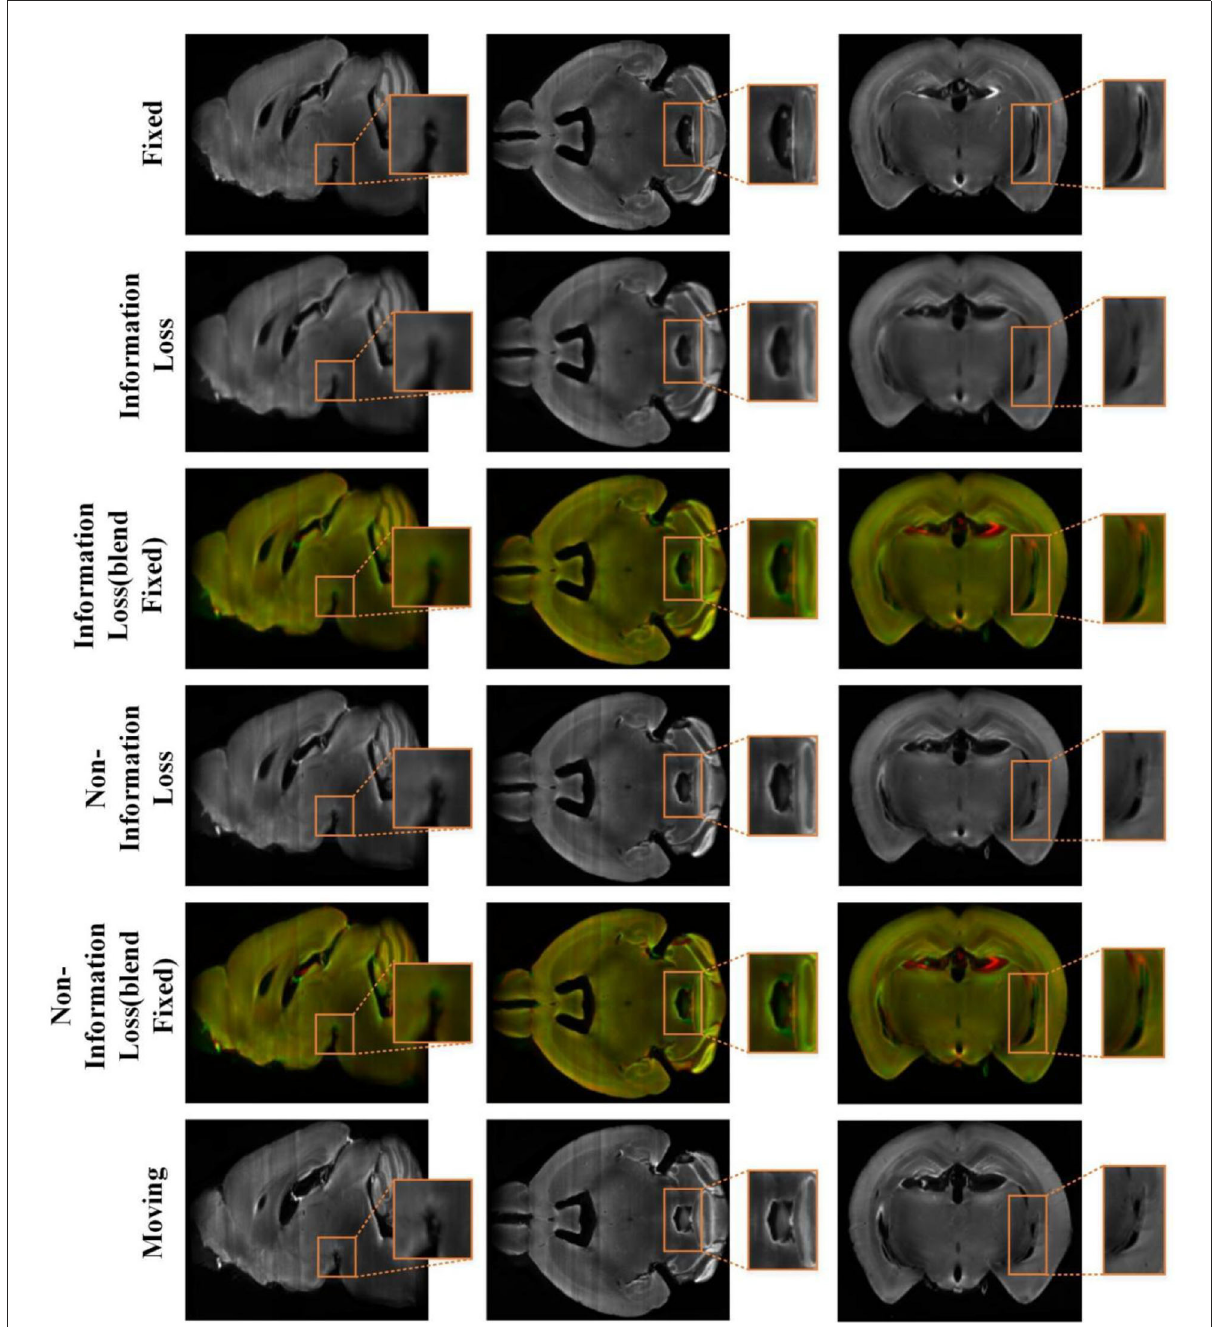
FIGURE8 The registration results of the conventional cascade registration method with information loss and our method on the mouse brain test set. And the visualization of 2D slices multi-channel color blend between the two registered results and the fixed image. The red channel is the fixed image and the green channel is the different registration results. The orange box is the part we want to highlight.